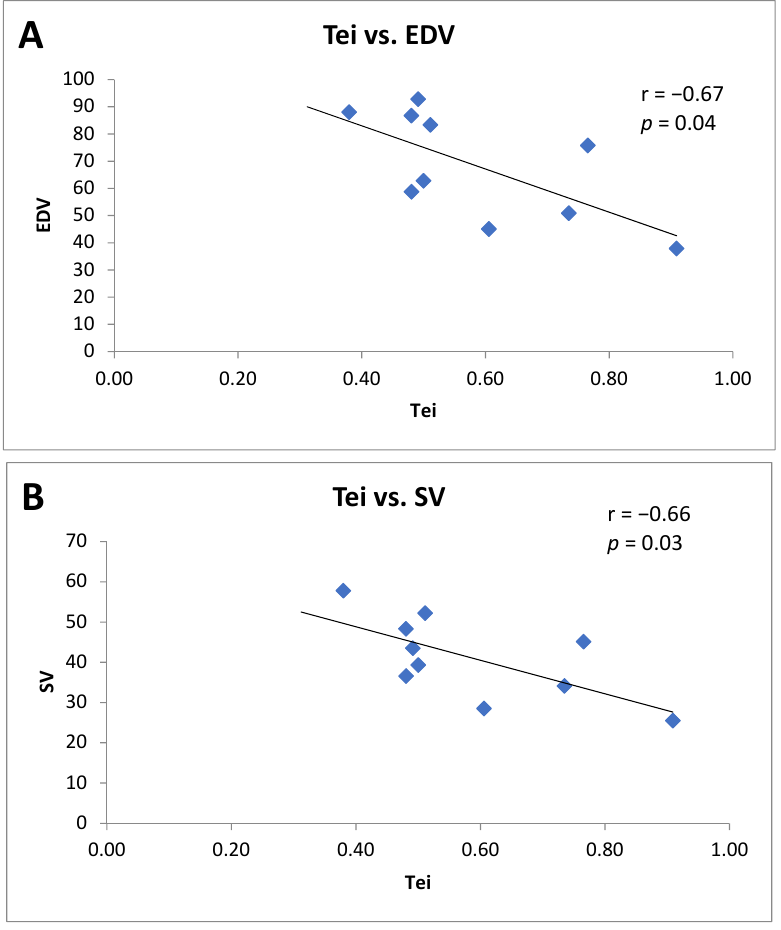
Figure 1. (A ) Correlation between theTei index value and the end diastolic volume (EDV) at 12 months of follow-up in Tei- patients. ( B ) Correlation between Tei index value and stroke volume (SV) at 12 months of follow-up in Tei- patients.